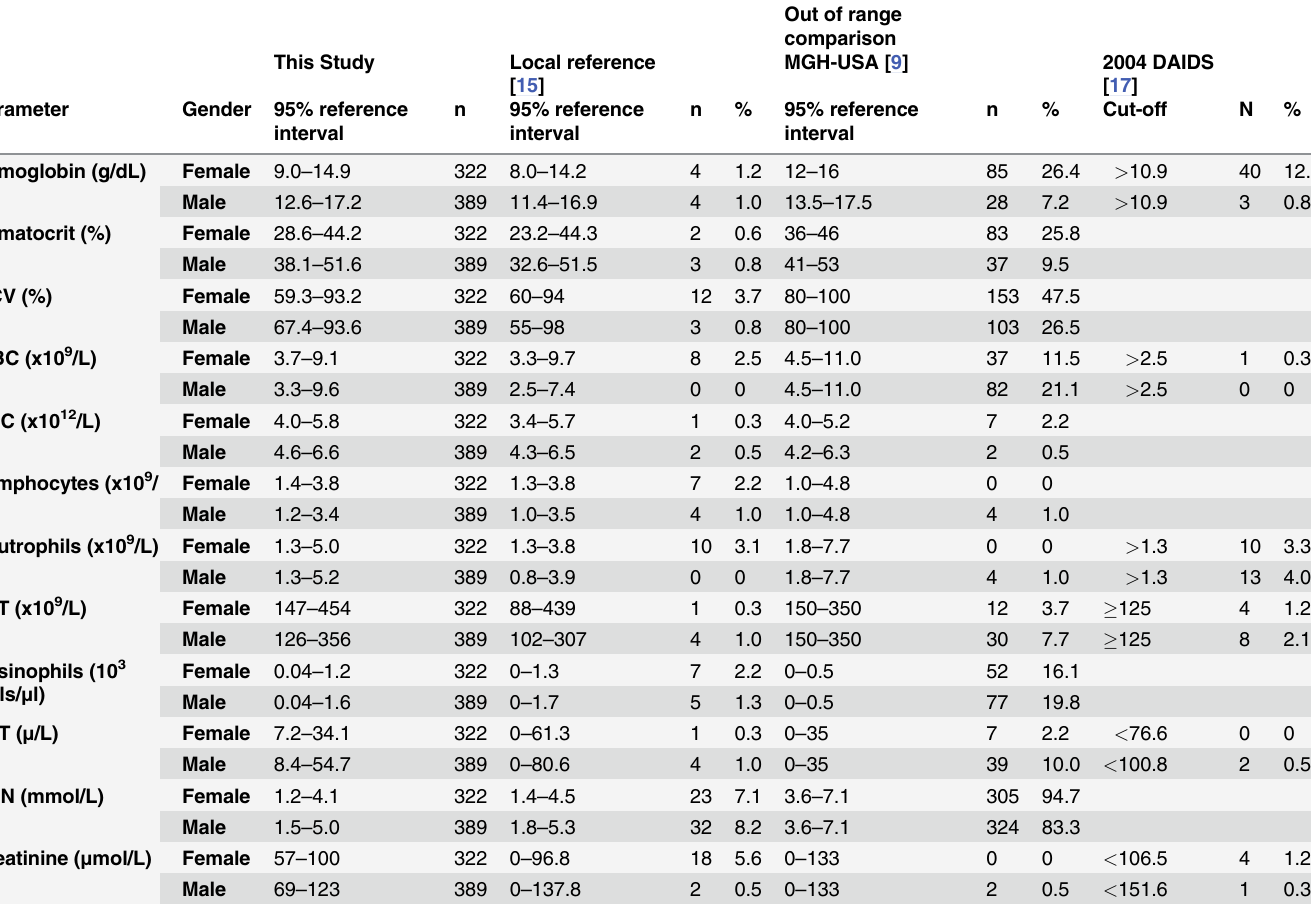
Table 5. Out of range and frequency of adverse events in the Kisumu Adult cohort obtained from comparison with values from locally-established reference intervals, DAIDS and North American derived MGH values.